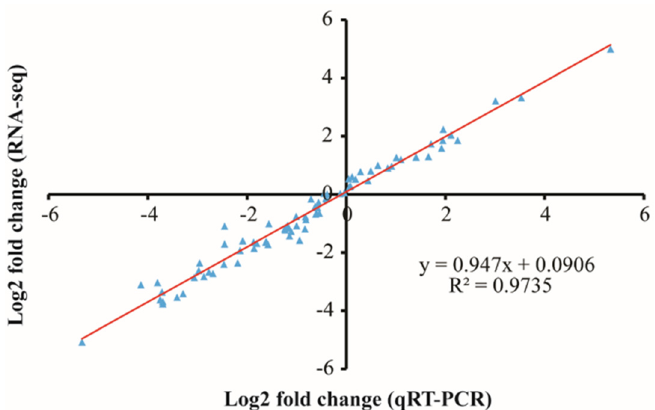
Figure 5. The qRT-PCR (quantitative reverse transcription-PCR) validation of differentially expressed genes under waterlogging stress. The qRT-PCR fold changes log2-values ( x -axis) were plotted against the RNA-seq fold changes’ log2-values ( y -axis).